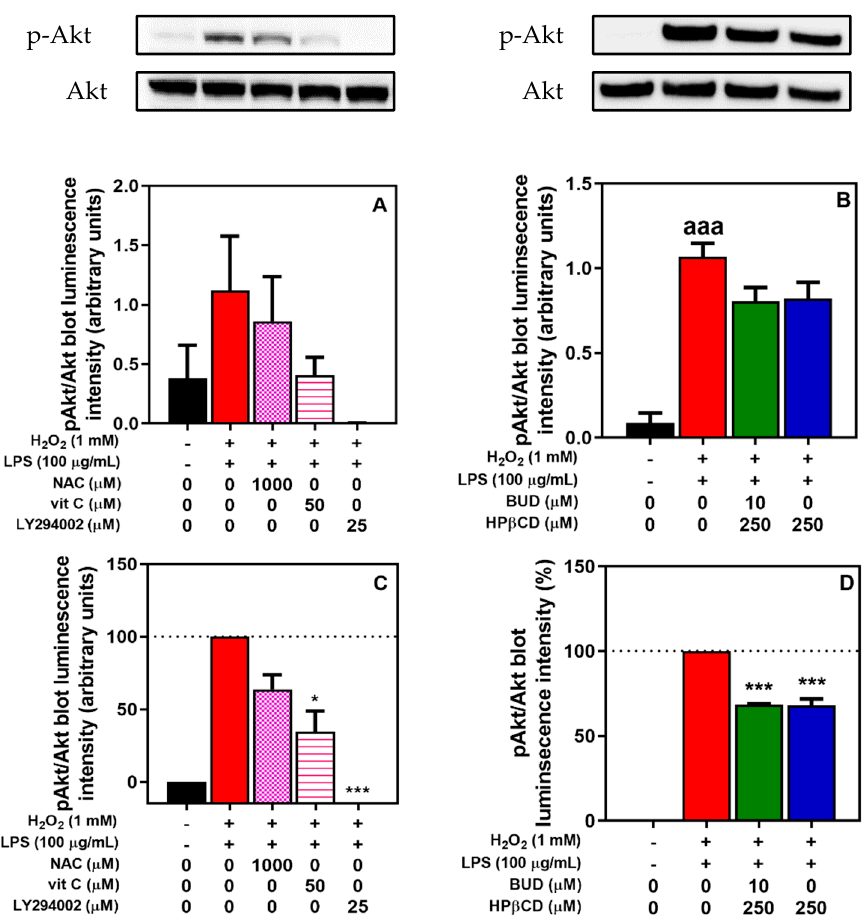
Figure 5. Akt phosphorylation induced by H 2 O 2 + LPS in A549 cells. Effect of N -acetyl-L-cysteine (NAC), vitamin C (VitC) and LY294002 ( A and C ) and BUD:HP β CD complex and HP β CD ( B and D ) after 2 h of incubation. Data are expressed in absolute values (A/B; with representative blots) or in relative values (in comparison with the pAkt/Akt ration of cells incubated with H 2 O 2 + LPS; C/D). Akt phosphorylation was quantified after a Western blot by measuring the proportion of phosphorylated-Akt (p-Akt) blot luminescence intensity/total Akt (Akt) blot luminescence intensity. Each bar represents the mean of 3 independent measures. A one-way ANOVA with Dunett post-test was used to compare the mean of each test group with the mean of untreated group or H 2 O 2 + LPS-treated group. The difference was considered significant for a p -value < 0.05. (aaa) correspond to p < 0.001 versus untreated group, (*) and (***) indicate p < 0.05, and 0.001 versus H 2 O 2 + LPS-treated group, respectively.